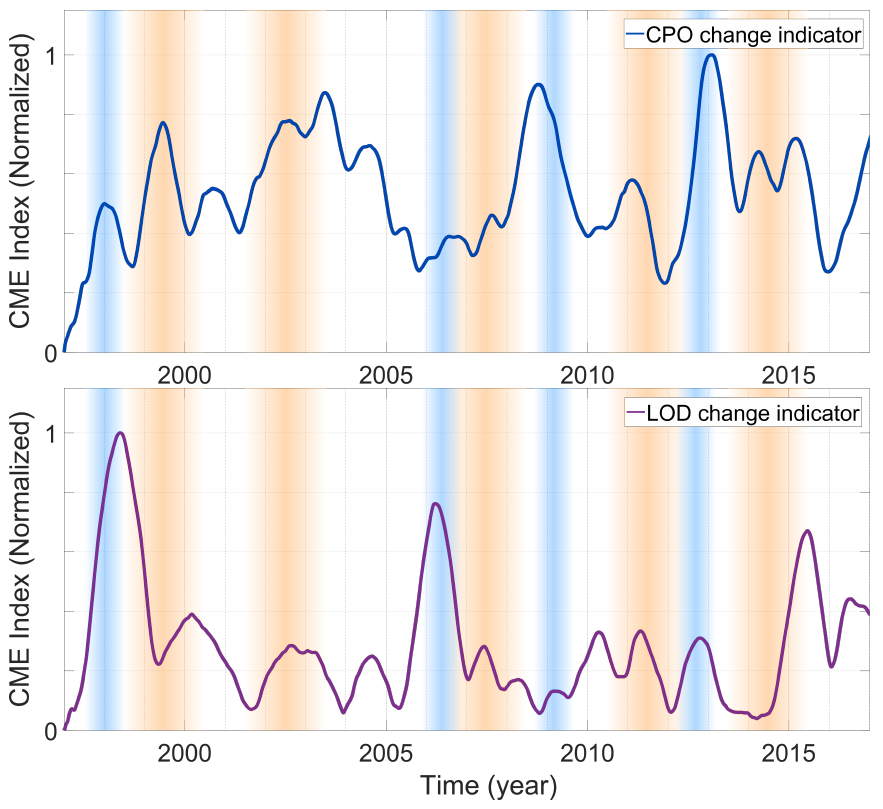
Figure 5. Detection of the time and significance of changes in the CPO (top) and LOD (bottom) time series based on Singular Spectrum Analysis (SSA). The blue-shaded areas indicate the epochs of SA pulses and the orange-shaded areas show reported geomagnetic